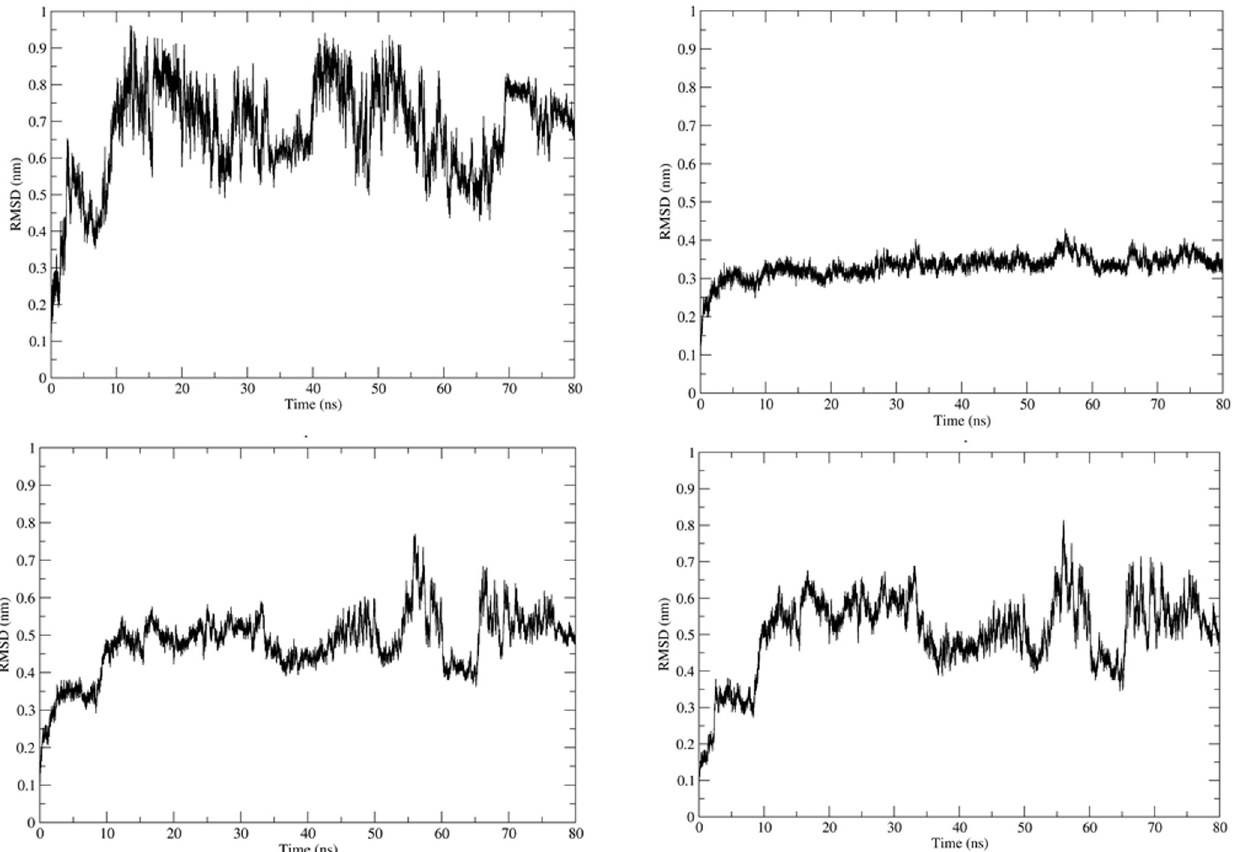
Fig 6. (a) RMSD of Peptide 7 in the complex. (b) RMSD plot of SARS-CoV RBD in the complex. (c) RMSD plot of peptide 7-SARS CoV RBD (d) Interface of Peptide 7 and SARS-CoV in the complex.